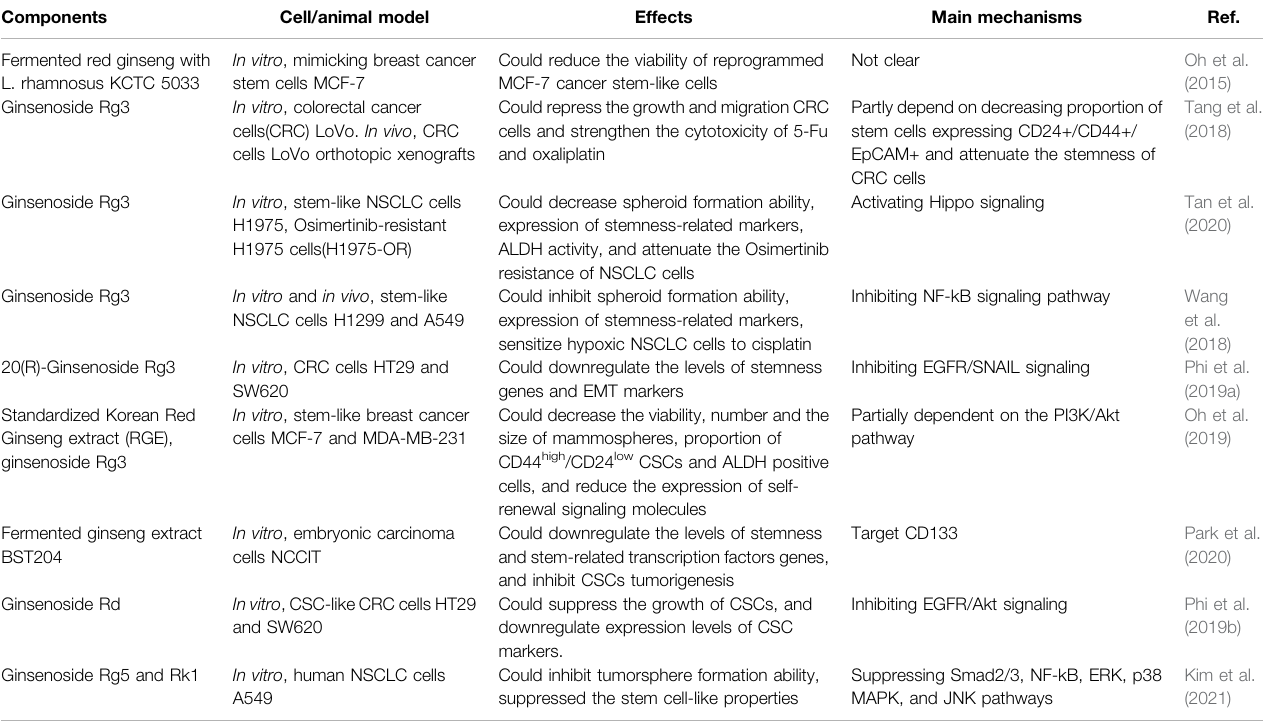
TABLE 3 | Effects of ginseng on cancer stem